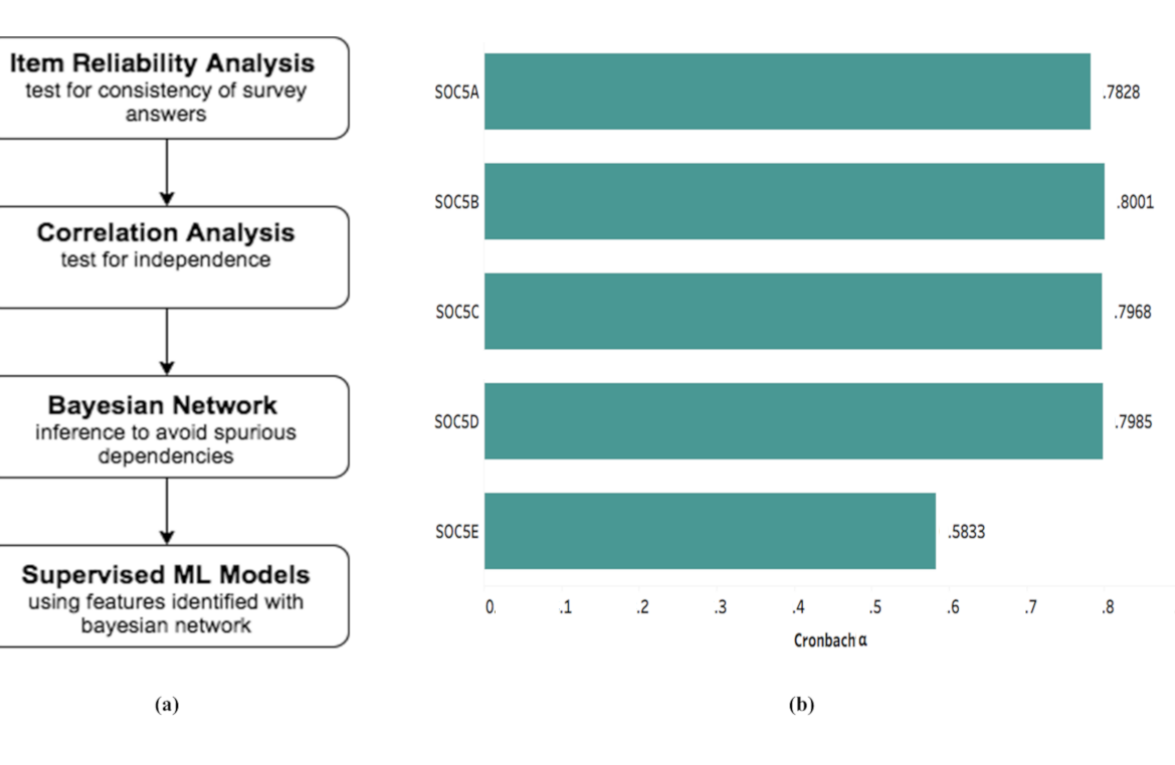
Figure 2. (a) Outline of the analytical pipeline. (b) Item reliability analysis of mental health indicators revealed a high degree of internal consistency (Cronbach alpha value >.70) for most of the psychological variables, thus indicating suitability for the modeling exercise. ML: machine